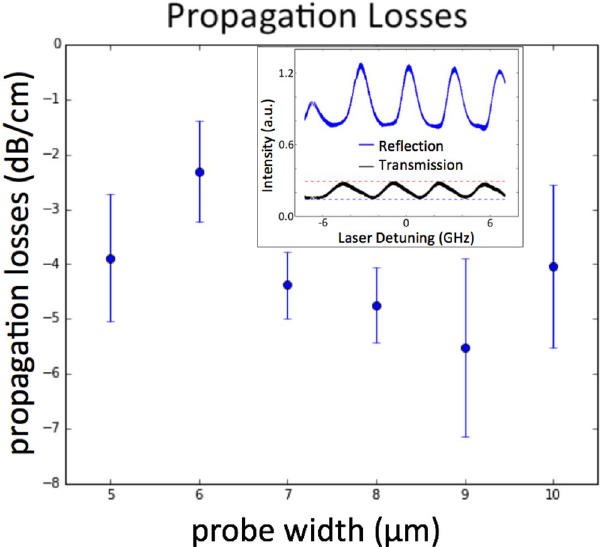
Figure 2. Figure 2 shows the estimated propagation losses for 10 μ m thick probes with waveguide widths ranging from 5 to 10 μ m wide. The propagation loss was extracted by measuring the transmission and reflectivity of the Fabry-Perot cavity 37–43 created between blunt polished end facets for a 10.2 μ m long probe, where 3.5 μ m of the waveguide length is released and 6.7 μ m of the waveguide length is clad (inset shows an example of the transmission and the reflection spectra).